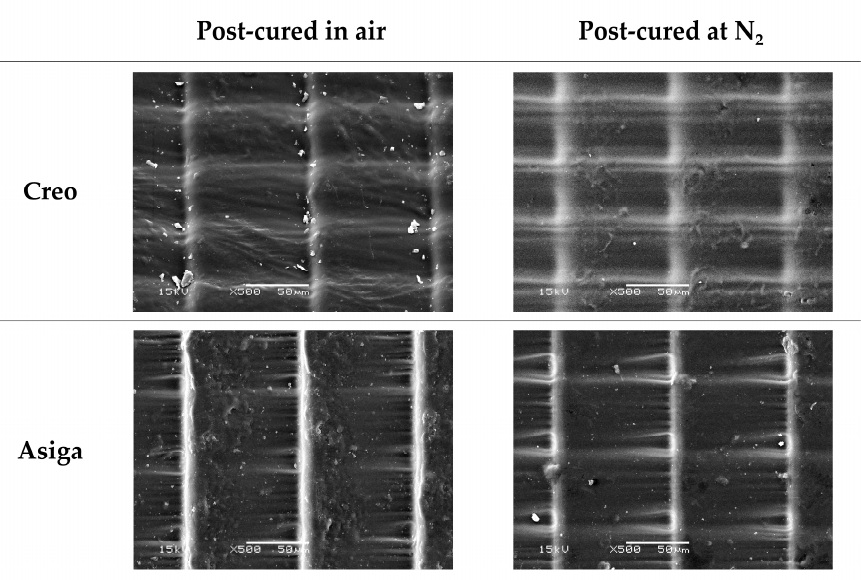
Figure 4. Scanning electron microscope (SEM) images ( × 500 at 15kV) of microlayer structures on the surface of typical specimens. Note the smoother surface on the Creo specimen post-cured at an N 2 atmosphere compared to other specimens.